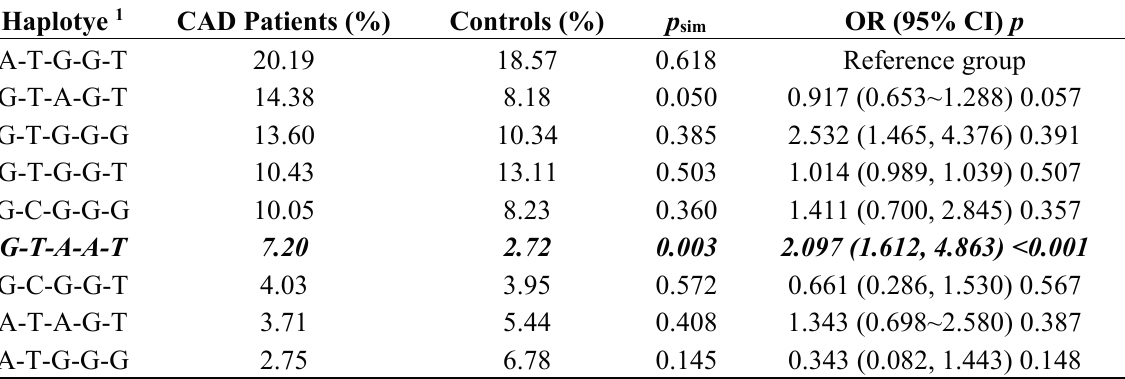
Table 5. Haplotype frequencies of five SNPs examined in DNMT1 gene between patients and controls and their risk prediction for